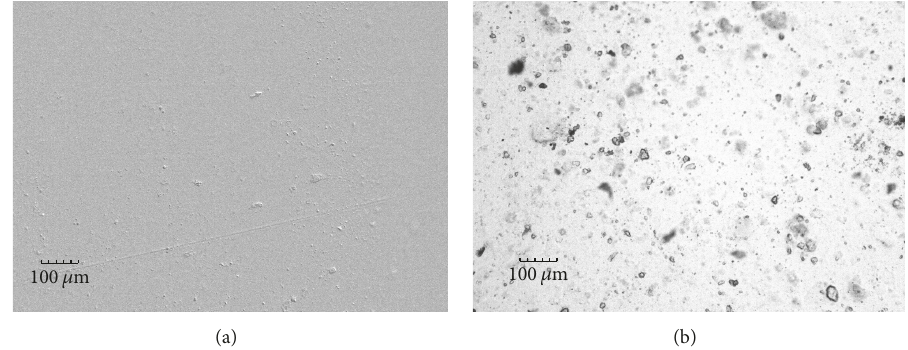
Figure 4: Optical micrographs of the HEC films filled with organobentonite, wt.% of filler: (a) – 0; (b) – 3.